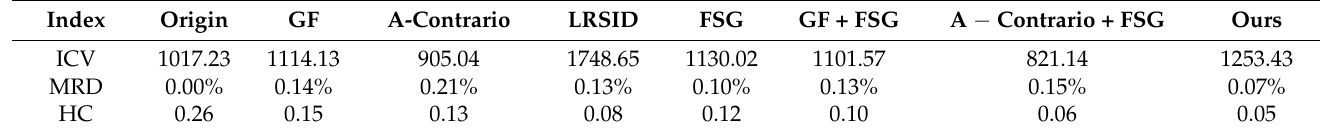
Figure 5. Comparison of actual image processing results of thermal imager: ( a ) origin. ( b ) GF. ( c ) A ‐ Contrario. ( d ) LRSID. ( e ) FSG. ( f ) GF + FSG. ( g ) A ‐ Contrario + FSG. ( h ) Ours. Table 3. Comparison of quantization index of actual image processing results of thermal